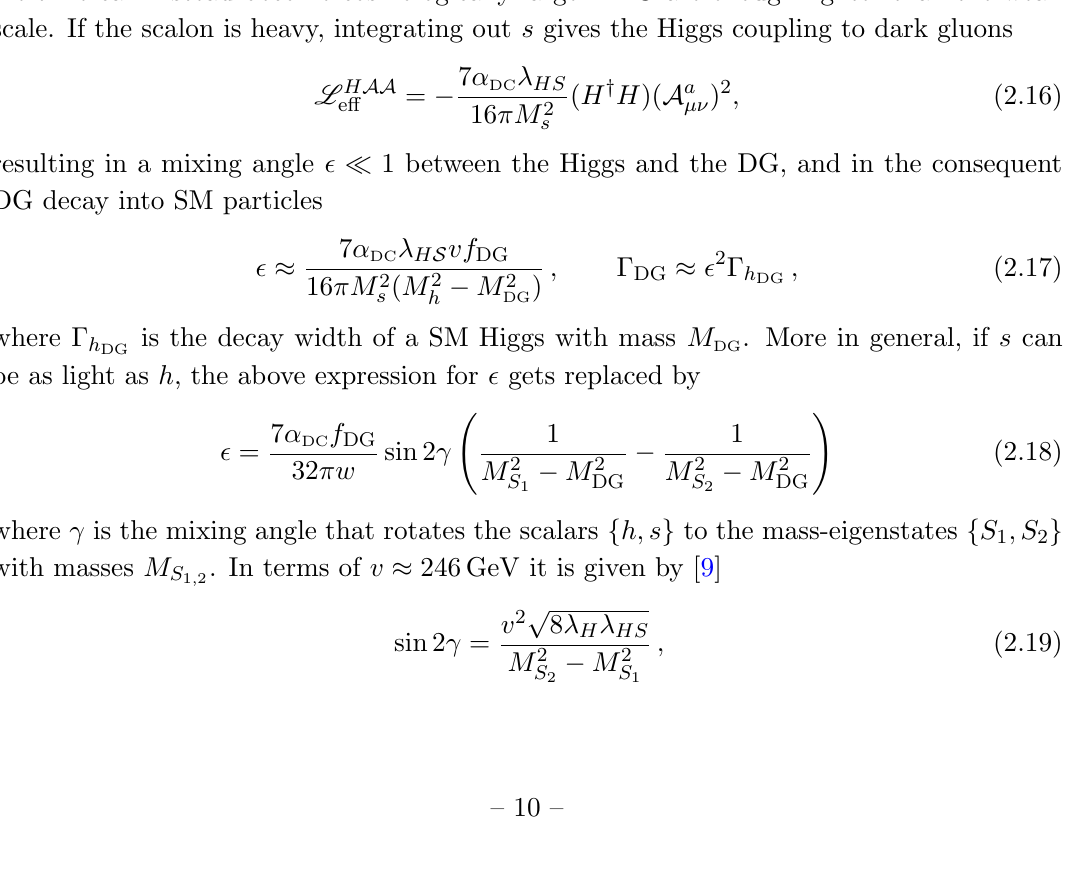
Figure 1 . Physical quantities are here computed as function of the two main scale parameters, the dark color con(cid:12)nement scale (cid:3) DC and the constituent mass M W = g DC w= 2. The boundary p between the Higgs and condensed phases ( g DC (cid:24) 4 (cid:25)= n i.e. (cid:3) DC (cid:24) M W ) is shown as dashed line. The cosmological DM abundance is reproduced along the green/red boundaries, computed for two di(cid:11)erent values of non-perturbative DM annihilation at con(cid:12)nement: the (thermal) Bohr radius and 1 = (cid:3) 2 . The latter possibility is relevant only if dark baryons do not fall cosmologically fast to DC their ground state. Numerical factors in the condensed phase are (cid:12)xed matching to the perturbative cross-sections in the Higgs phase. We also show, as dotted curves, the same boundary computed assuming that some extra new physics gives fast glue-ball decays. The the upper gray region is excluded by BBN because of too slow DG decays and we also show limits from direct [31] and indirect [32] detection (plotted assuming the cosmological DM abundance). Future prospects are shown as dashed